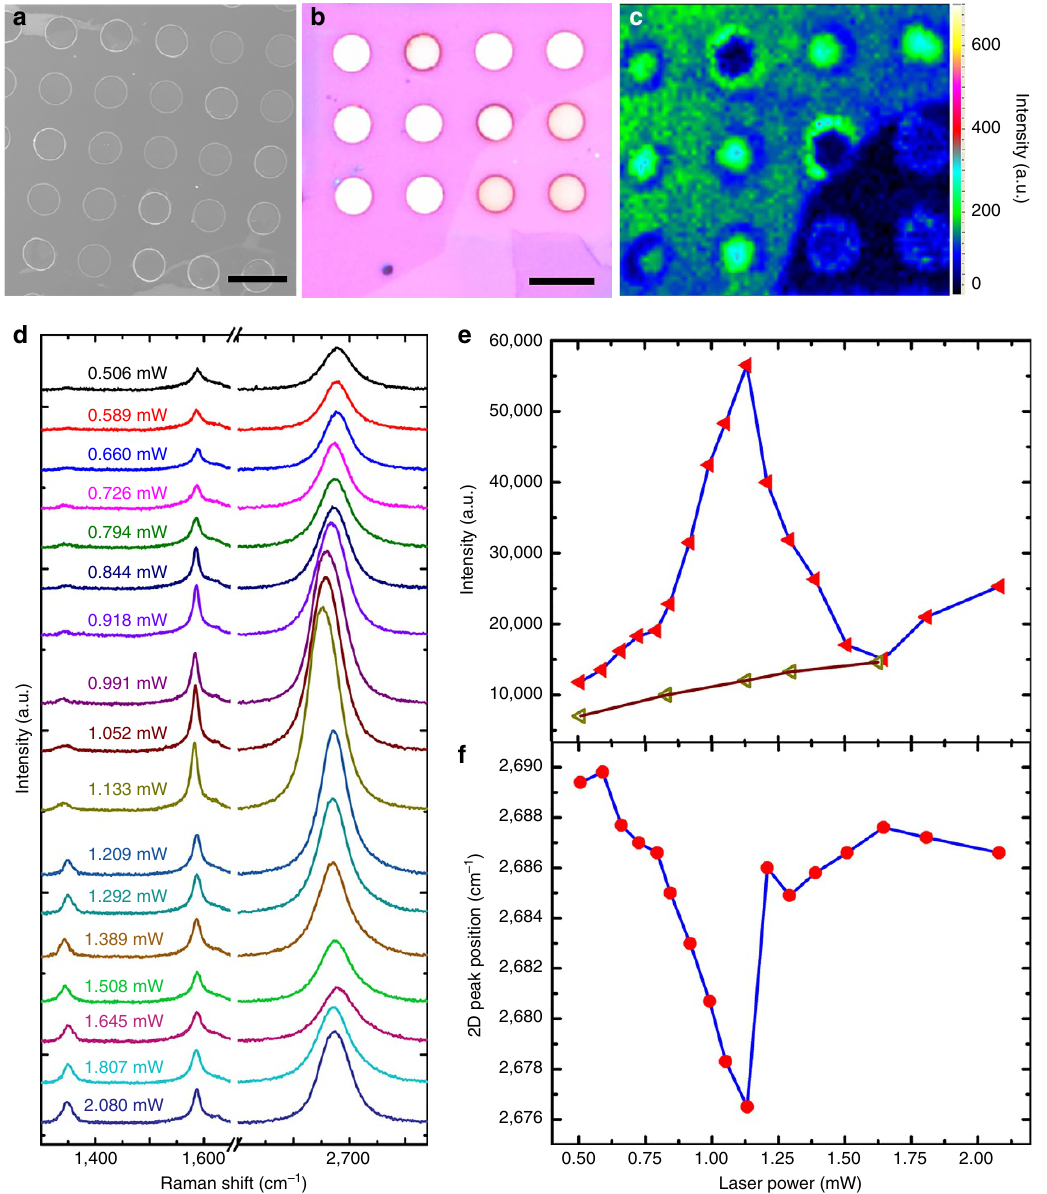
Figure 3 | Thermal transport of graphene films with B 200nm-sized grains. ( a ) SEM image of a polycrystalline graphene film on a holey SiO 2 /Si substrate. Scale bar, 10 m m. ( b ) Optical image of a polycrystalline graphene film transferred onto a holey SiO 2 /Si substrate. Scale bar, 10 m m. ( c ) Raman map of the polycrystalline graphene film shown in b , and the typical Raman spectra are shown in Supplementary Fig. 12. ( d ) Raman spectra of the polycrystalline graphene film excited with different power lasers. ( e , f ) Intensity ( e ) and position ( f ) of the 2D peak as a function of laser